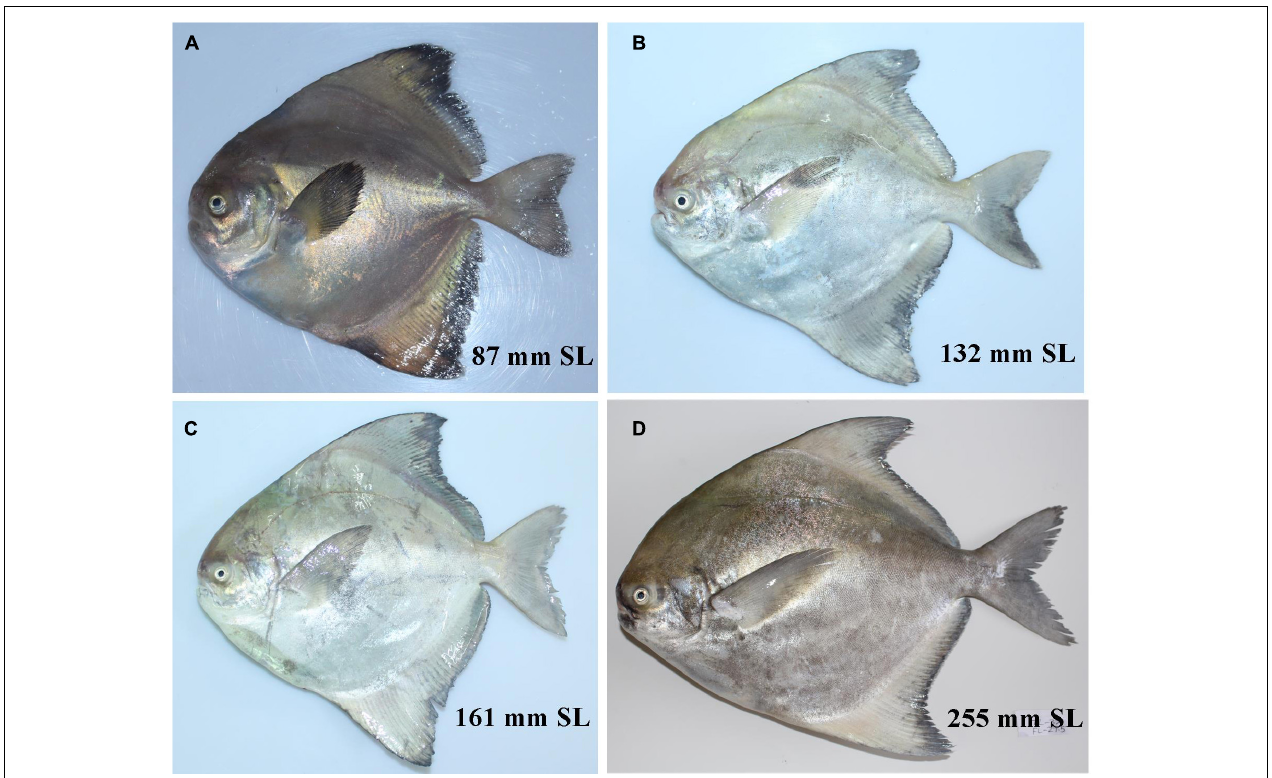
FIGURE 9 | Pampus chinensis . (A) Juvenile, (B,C) subadult, and (D) adult